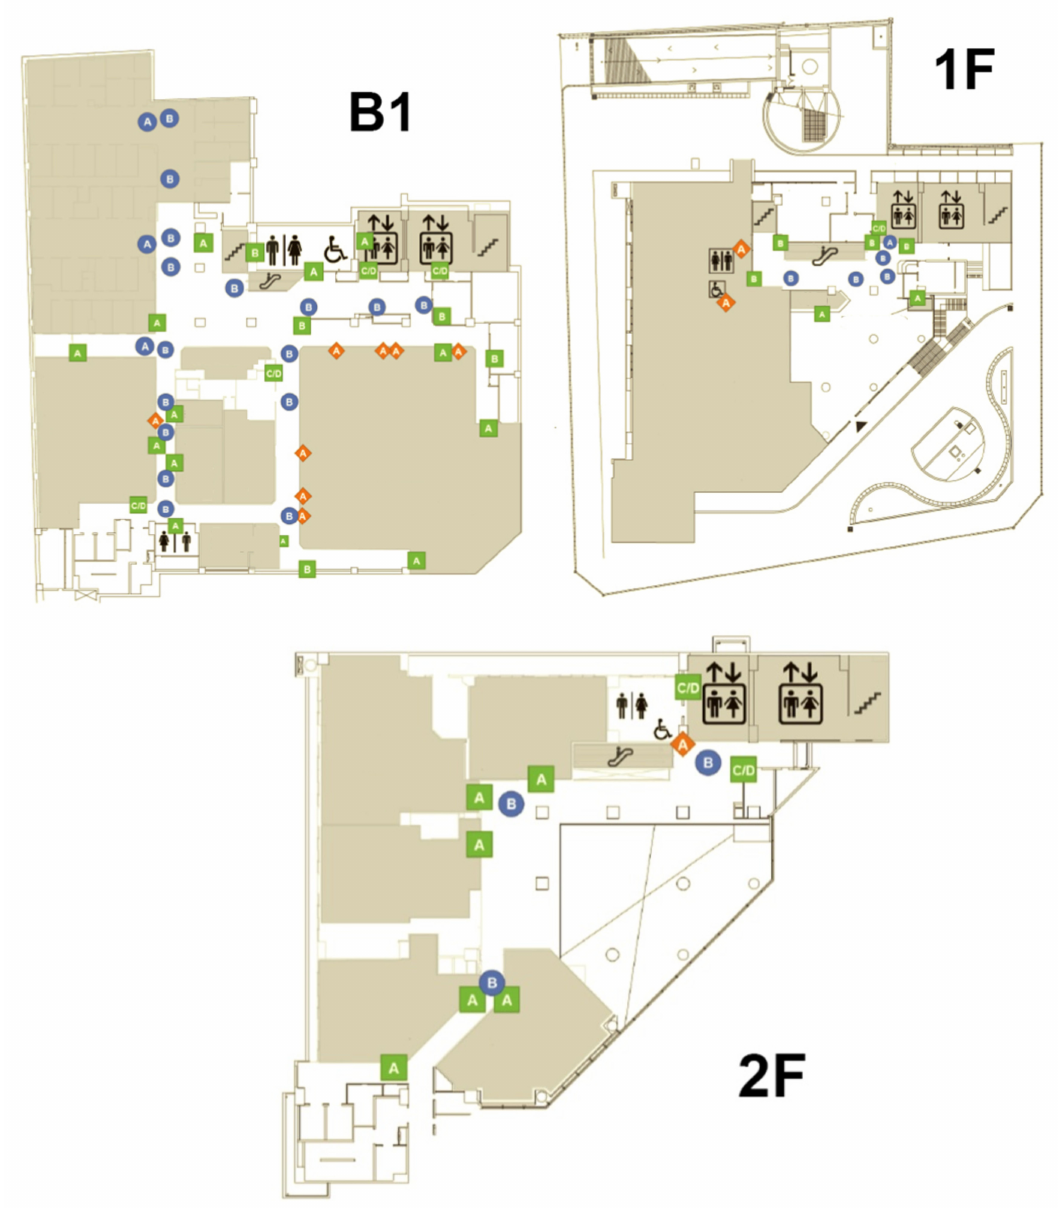
Figure 5. The signage configuration and distribution of the outpatient areas B1 to 2F in CCH/CKB. The results showed that there are seven categories and 82 signs in the outpatient area from the first basement floor to the second floor. Among them, the distribution of the up hanging type with guidance contents has a maximum of 23 signs, accounting for 28.05% of the total. Next is the signage of the wall-mounted type with identification contents with 21 examples, accounting for 25.61% of the total. In addition, in terms of floor distribution, the number and types of the signage are the most on the first basement floor due to its larger area and more clinic and examination rooms, with a total of seven categories and 53 signs. The number and type distribution of the signage on each floor is shown in Table